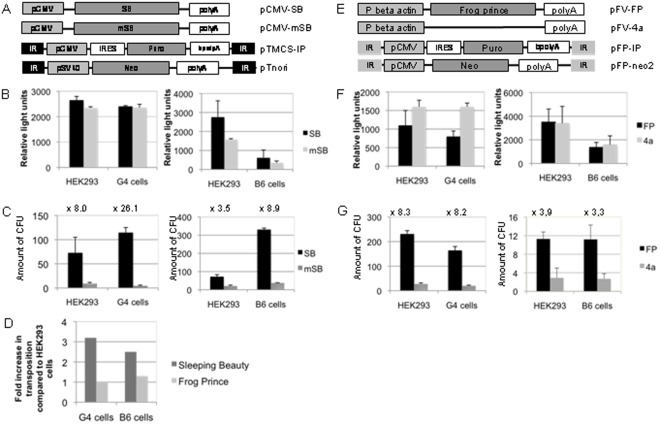
Influence of the RNA interference (RNAi) pathway on integration events mediated by Sleeping Beauty (SB) transposase and Frog Prince (FP) transposase.(A) Shown are all DNA constructs used to analyze the influence of the RNAi pathway on SB mediated transposition in HEK293 cells and the RNAi knockdown cell lines G4 and B6. The vector pTnori with the neomycin resistance gene was used as a transposon donor vector in G4 cells and pTMCS-IP was used in B6 cells. pCMV: major immediate early promoter/enhancer; IRES: internal ribosome entry side of the encephalomyocarditis virus (ECMV); Puro: puromycin-N-acetyl-transferase gene mediates puromycin resistance; bpolyA: bovine growth hormone A polyA signal; polyA: SV40 polyA signal; Neo: neomycin resistance cassette mediating G418 resistance; SB: SB transposase; mSB: mutated version of the Sleeping Beauty transposase; IR: inverted repeats recognized by SB. (B) Analysis of transfection efficiencies in HEK293, G4 (left panel) and B6 cells (right panel) two days post-transfection of the DNA constructs used for SB-mediated transposition. Instead of 100 ng stuffer plasmid as used for integration assays, 100 ng of the renilla luciferase expressing plasmid pRL-TK were transfected into 6-well plates and relative light units were determined. For details please refer to the material and methods section. The amount of relative light units correlates with the transfection efficiency. (C) Total number of colony forming units (CFUs) after SB transposase mediated integration in HEK293 cells and the RNAi knockdown cell lines G4 (left panel) or B6 (right panel). The fold increase in transposition events compared to the inactive protein is shown in numbers above the respective bars. All experiments were performed in triplicates and were statistically relevant (p-value<0.05). *: p-value<0.05. (D) The fold increase in integration events directly comparing the parental cell line HEK293 and the respective RNAi knockdown cell line for the SB transposase and the Frog Prince (FP) transposase are shown. (E) Shown are all DNA constructs used to analyze the influence of the RNAi pathway on FP mediated transposition in HEK293 cells and the RNAi knockdown cell lines G4 and B6. The transposon donor vector pFP-IP with the puromycin resistance gene was used in B6 cells and pFP-neo2 was used in G4 cells. P beta actin: beta actin promoter; FP: Frog Prince transposase; 4a: empty vector without FP transposase; IR: inverted repeats recognized by FP. (F) Analysis of transfection efficiencies in HEK293, G4 and B6 cells for the FP transposase system two days post-transfection. The amount of relative light units correlates with the transfection efficiency. (G) Total number of CFUs after Frog Prince mediated transposition in HEK293 cells and the RNAi knockdown cell lines G4 (left panel) or B6 (right panel). The fold increase in transposition events is expressed in numbers above the respective bars. The data comparing the active transposase with its inactive version within one cell line are statistically relevant (p-value<0.05). All experiments were performed in triplicates. * p-value<0.05.